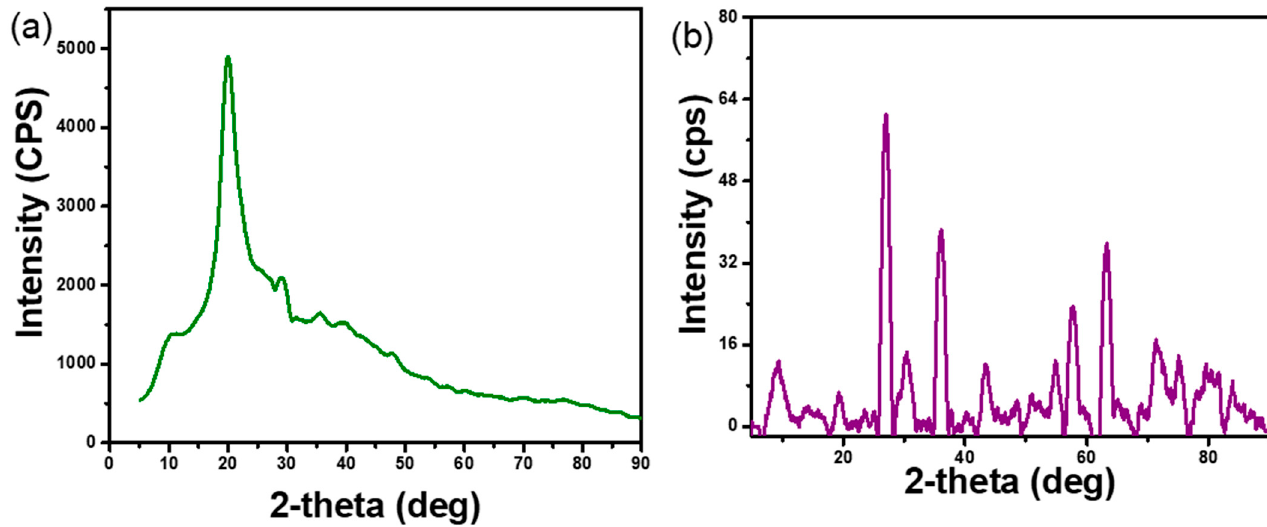
Figure 5. XRD patterns of ( a ) Chitosan and ( b ) m-CGPA.